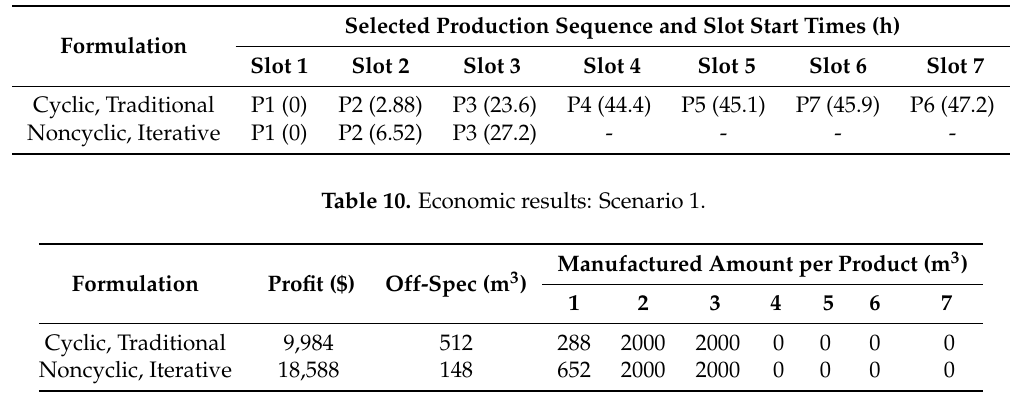
Table 9. Production schedule: Scenario 1.